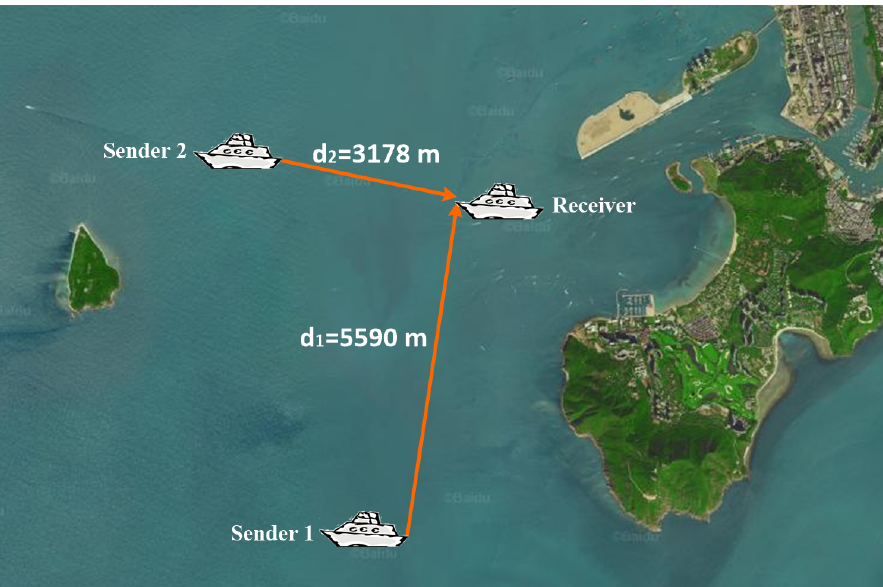
Figure 9. Network topology of sea